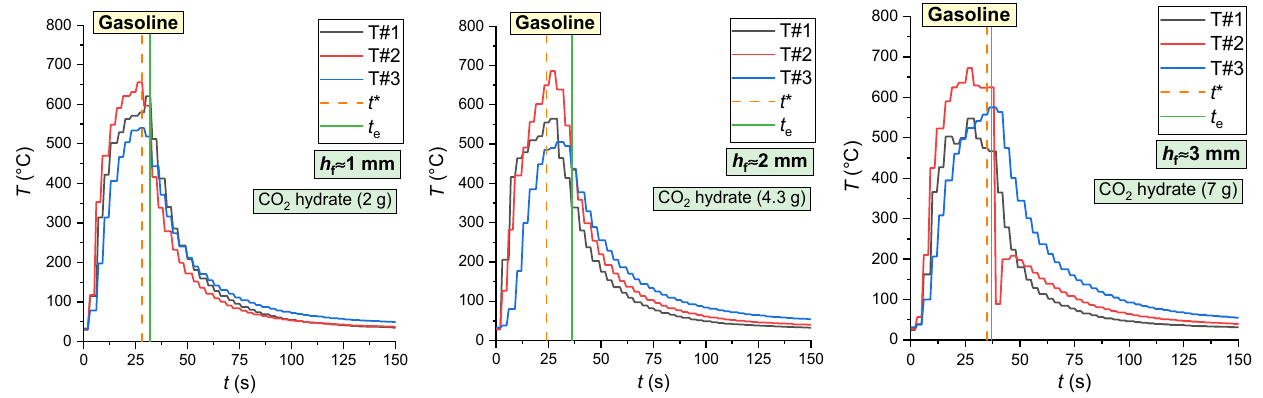
Figure 15. Flame temperature variation dynamics (gasoline, V 0 ≈ 9 mL, d f ≈ 65 mm, S f ≈ 33 cm 2 ) of laboratory-scale fires suppressed by CO 2 hydrate powder with varying thickness of the fuel film (layer).